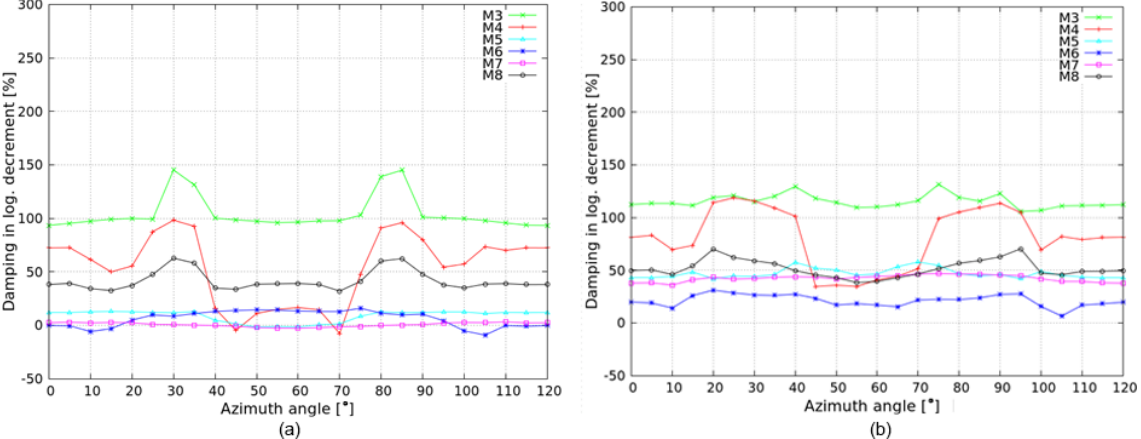
Figure 24. Modal damping of rotor modes versus azimuth angle at U = 42 . 5ms − 1 and yaw = 60 ◦ . (a) Steady-state aerodynamics and (b) unsteady aerodynamics (ONERA